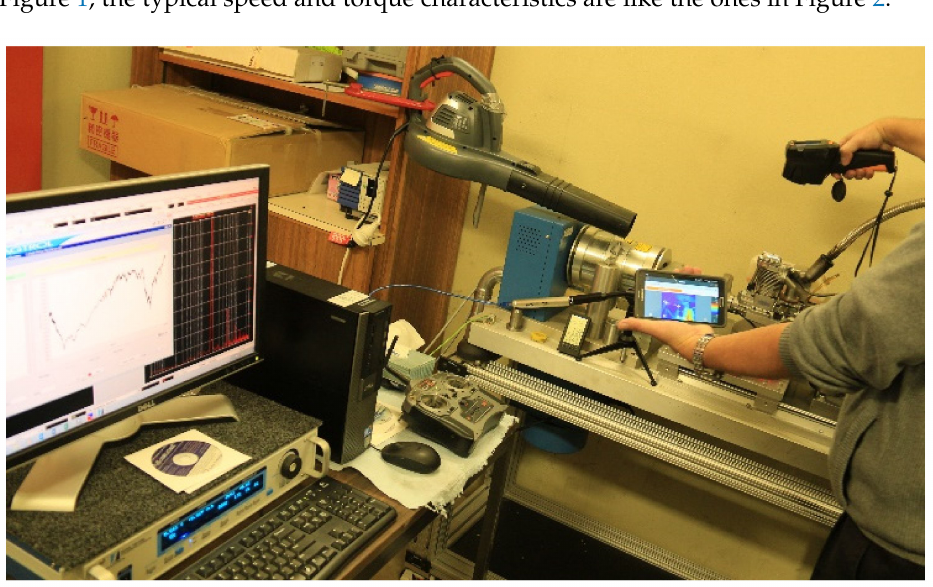
Figure 1. Dynamometer experiments on a Saito FG-40 engine.